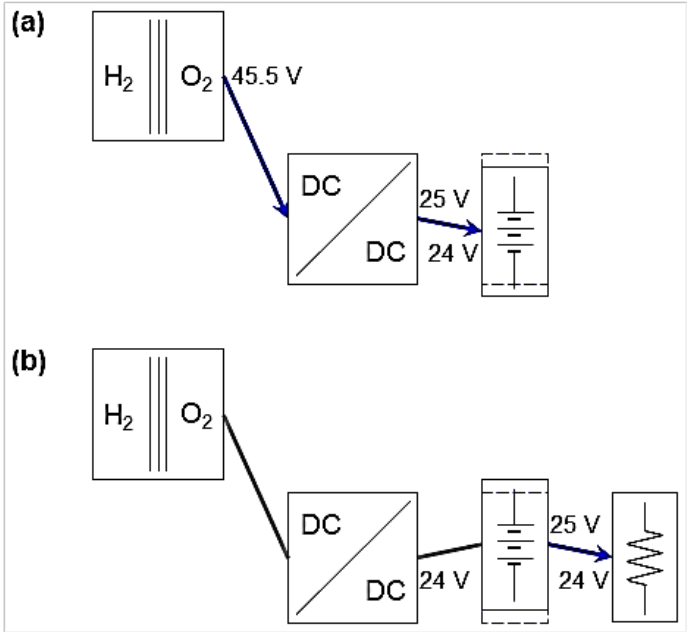
Figure 3. Variations in the power flow within the selected structure. ( a ) Incoming to battery and ( b ) outgoing from battery.